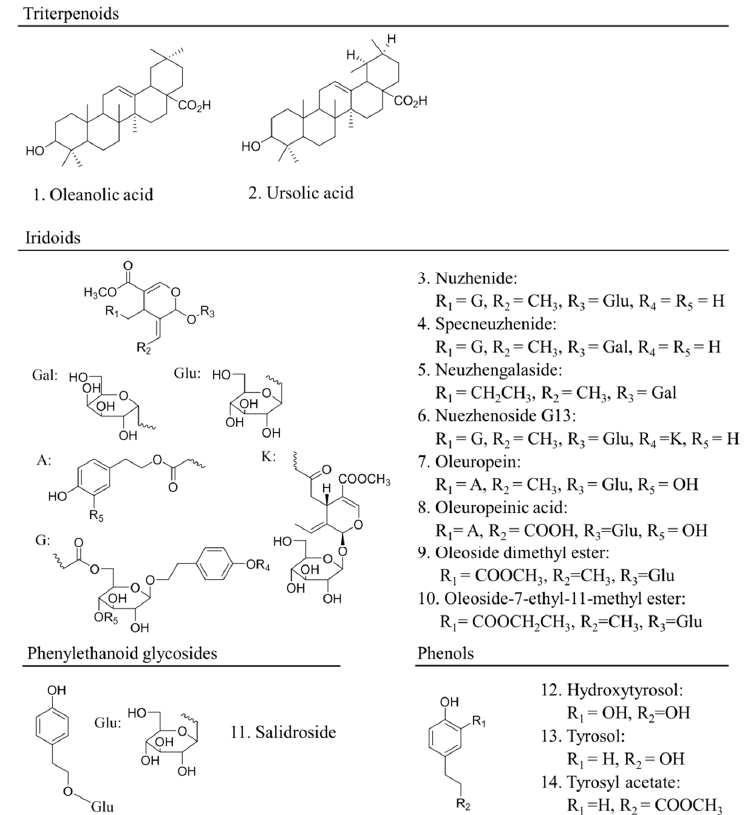
Figure 2. The chemical structures of the main active ingredients isolated from Fructus Ligustri Lucidi : ( 1 ) oleanolic acid; ( 2 ) ursolic acid; ( 3 ) nuzhenide; ( 4 ) specneuzhenide; ( 5 ) neuzhengalaside; ( 6 ) nuezhenoside G13; ( 7 ) oleuropein; ( 8 ) oleuropeinic acid; ( 9 ) oleoside dimethyl ester; ( 10 ) oleoside-7-ethyl-11-methyl ester; ( 11 ) salidroside; ( 12 ) hydroxytyrosol; ( 13 ) tyrosol; ( 14 ) tyrosyl acetate.